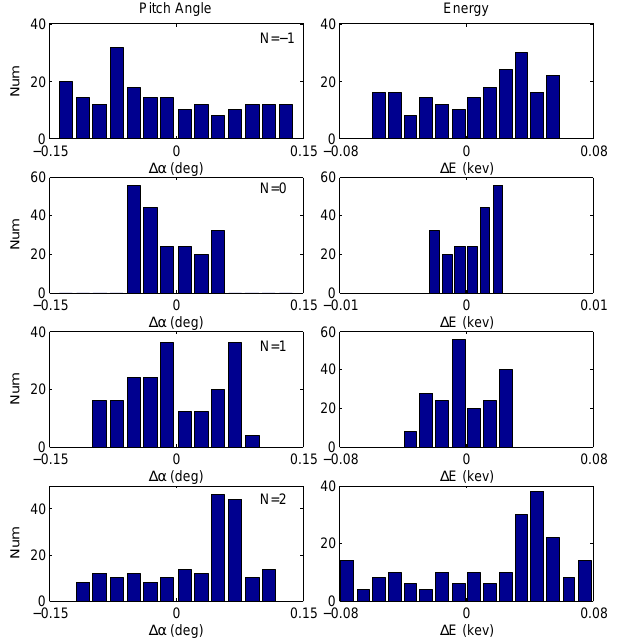
Figure 6. Corresponding to the bottom panels of Fig. 5, histograms showing the number distribution of 200 test electrons with respect to relative change in pitch angle and energy, that is, 1α (left panels) and 1 E (right panels), for the resonance harmonics N = − 1, 0, 1, and 2.